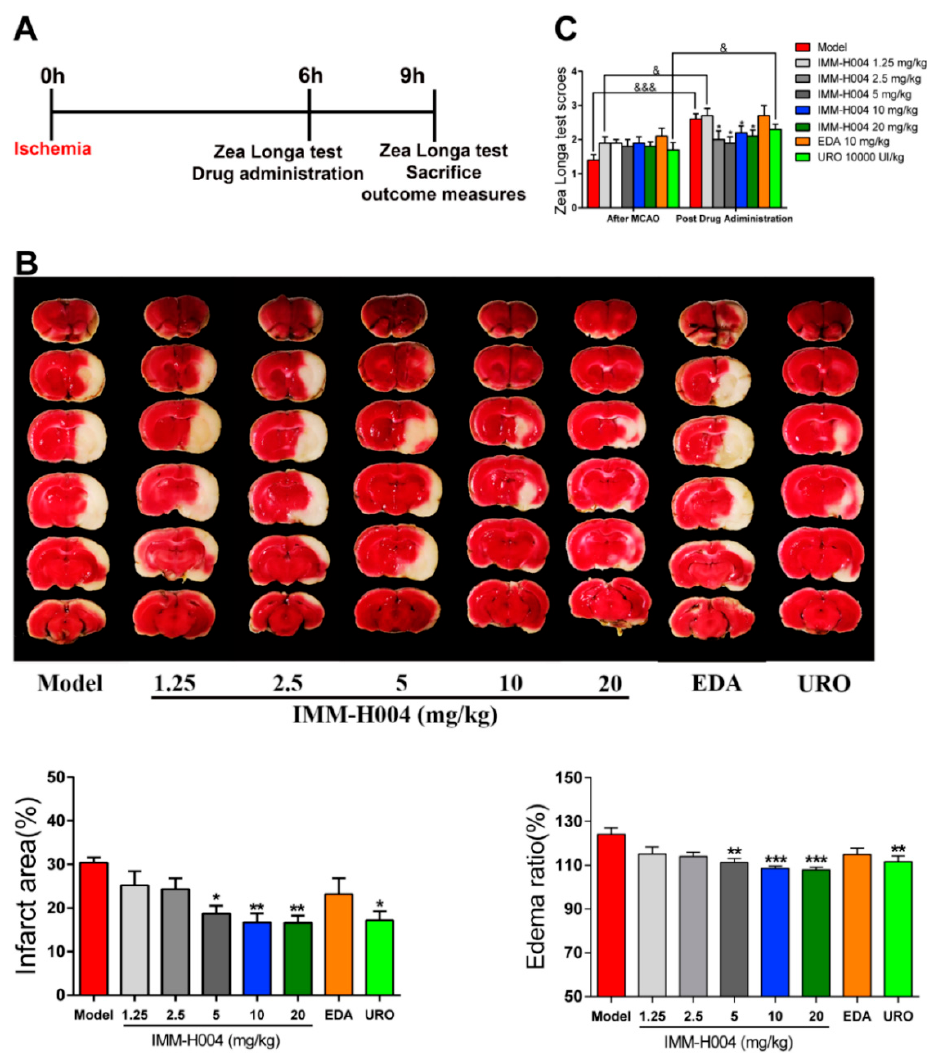
Figure 2. Therapeutic dosage window experiment of IMM-H004. ( A ) The timeline diagram of theraputic dosage window experiment. ( B ) Representative images of TTC staining, and analysis of infarction area and edema ratio. ( C ) Statistical analysis of Zea Longa test scores. Data are shown as the mean ± SD ( n = 10/group). * p < 0.05 vs. model; ** p < 0.01 vs. model; *** p < 0.001 vs. model; & p < 0.05 vs. after MCAO; &&& p < 0.001 vs. after MCAO.